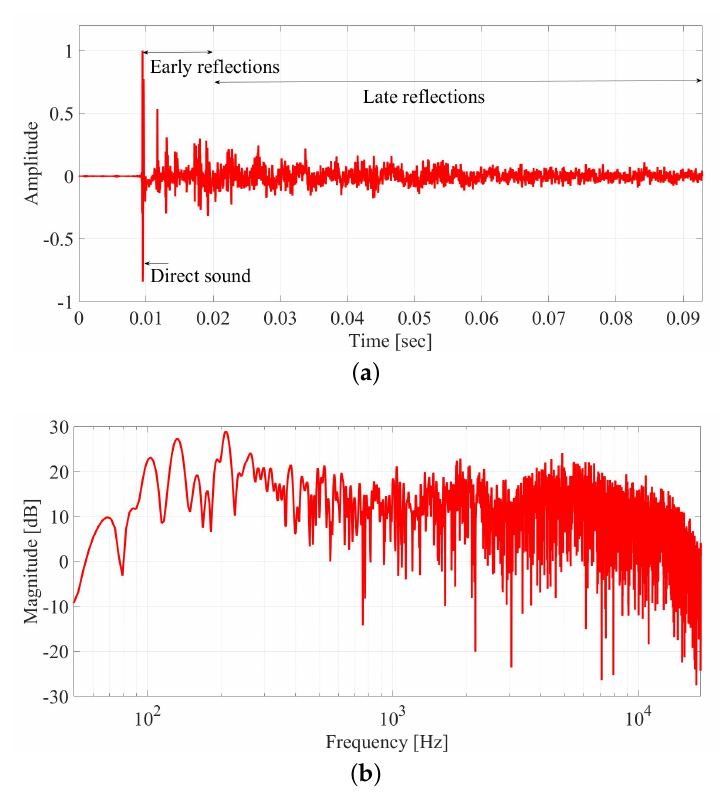
Figure 2. Real RIR behaviour ( a ) in the time domain and ( b ) in the frequency